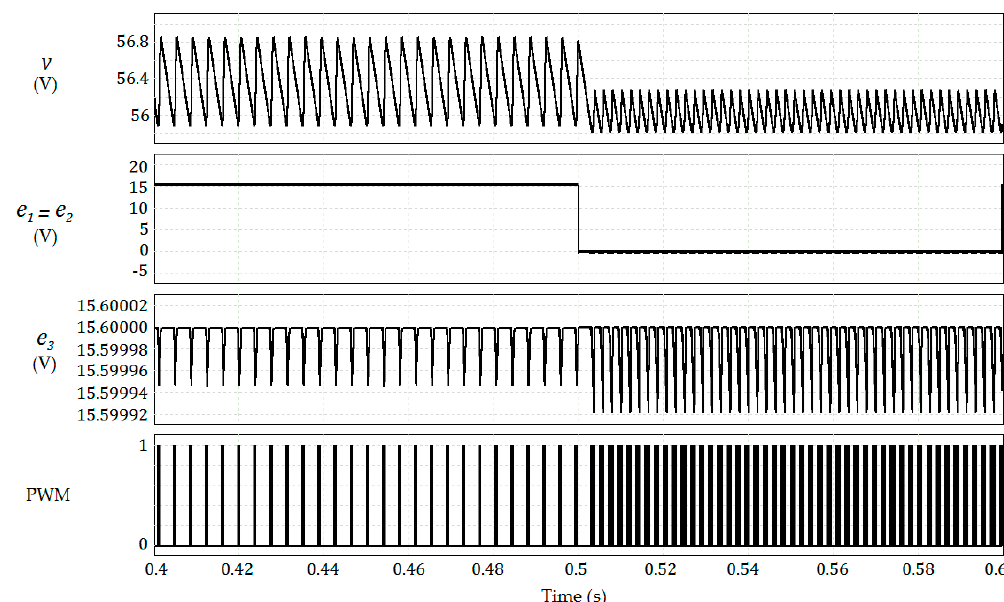
Figure 3. PI closed-loop behavior with e 1 = e 2 drop to zero at 0.1 s.